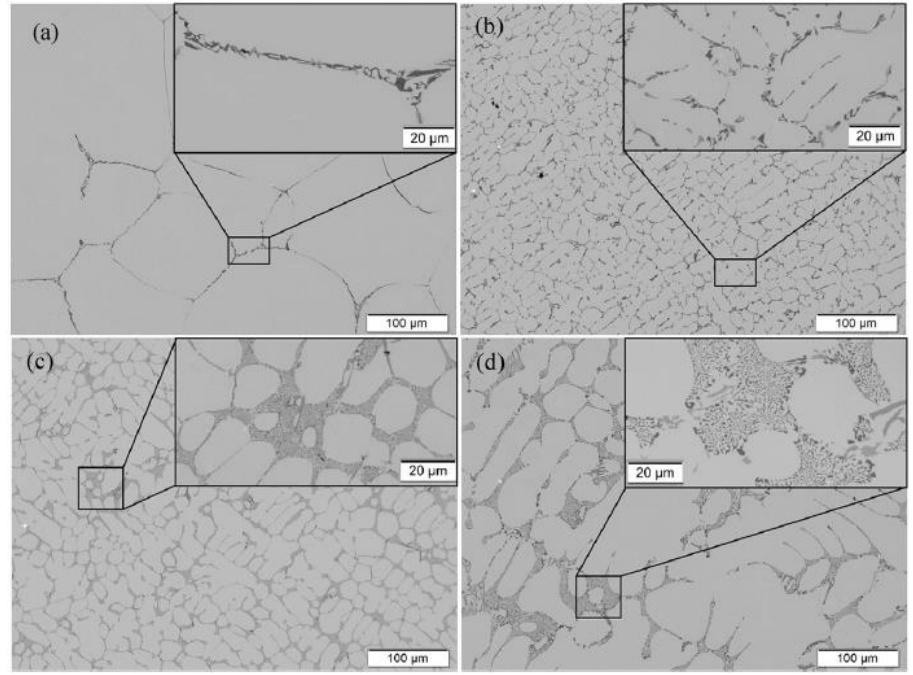
Figure 16. Microstructures of samples: ( a ) alloy A (2.43 wt % Si), high cooling rate; ( b ) alloy C (5.45 wt % Si), high cooling rate; ( c ) alloy C M (5.45 wt % Si), high cooling rate; ( d ) alloy C M (5.45 wt % Si), low cooling rate. Reprinted with permission of [99].